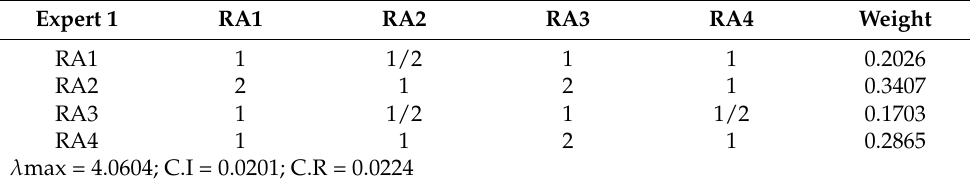
Table 8. Consistency and weight values of the surface.